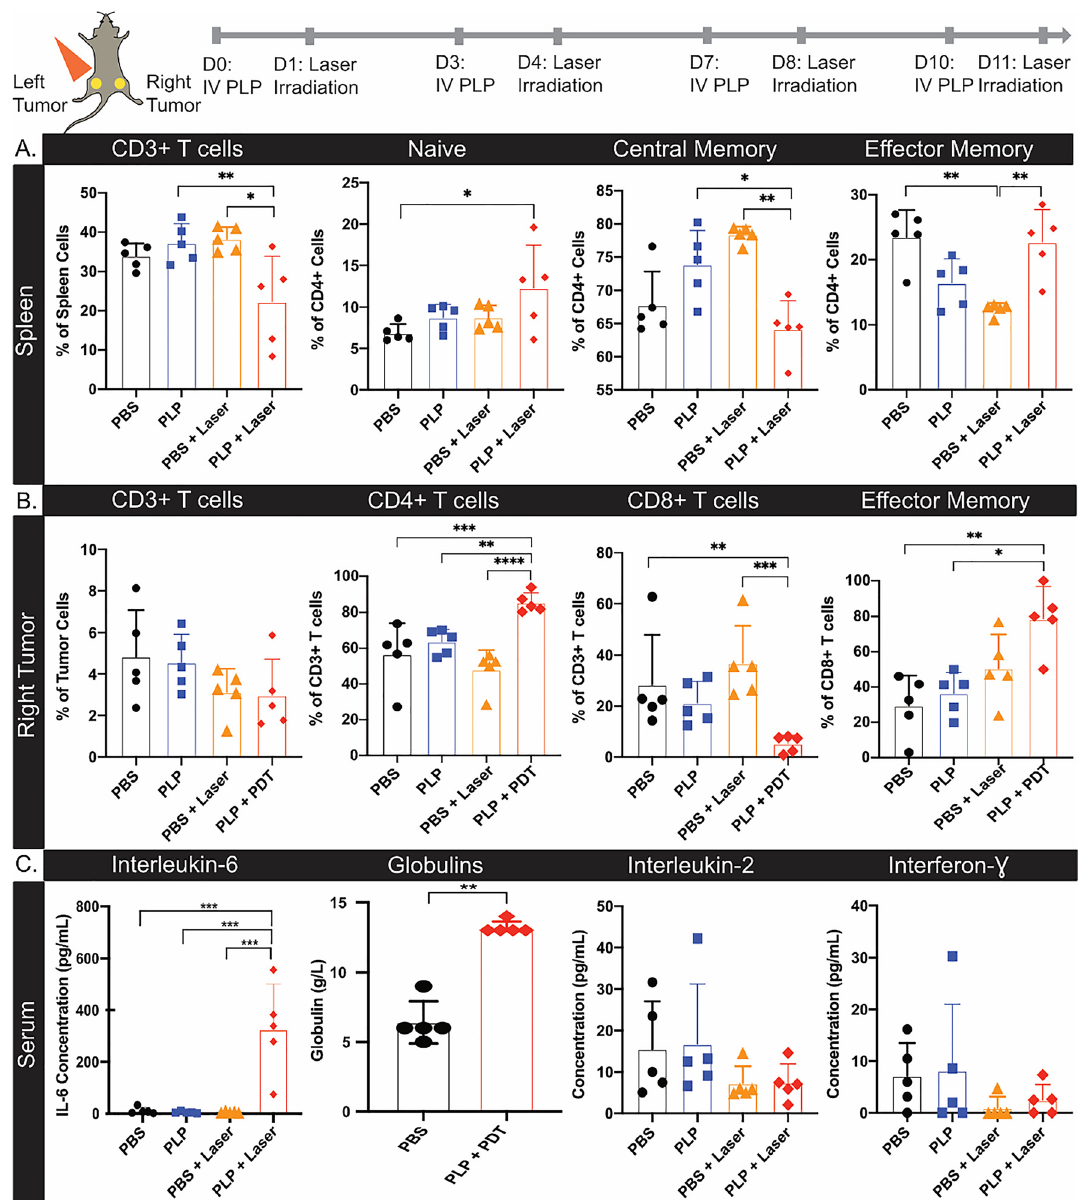
Figure 5: The abscopal effect involved CD4 + and CD8 + T cells. (A)Dualsubcutaneous AE17-OVA + tumorbearingmiceweretreatedwithfourcyclesofPBS,PLP(4mg/kg),laserirradiationat50J/cm 2 ,orPDT (PLP + laser). Mice were sacri fi ced on day 14 and spleens and right tumors were harvested for fl ow cytometry, while serum was collected for cytokineanalysis.SummaryofthepercentageofCD3 + Tcells,naive,centralmemory,andeffectormemoryCD4 + Tcellsinthespleenoftreated mice. (B) Summary of the percentage of CD3 + T cells, CD4 + T cells, CD8 + T cells, and effector memory CD8 + T cells in the non-irradiated, right tumorsof treatedmice. (C) Assessment of theconcentrationof interleukin-6, globulins, interleukin-2, and interferon-gamma in serumof mice ( n =5).Dataaremean ± standarddeviation.Statisticalsigni fi cancewasdeterminedusingaone-wayANOVA,followedbyaposthocTukeytest. n = 5, *p < 0.05, **p < 0.01, ***p < 0.001, ****p <